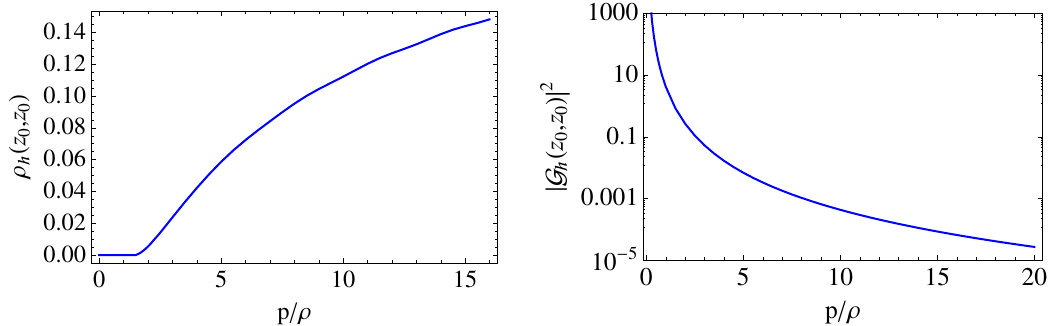
Figure 7 . Left panel: spectral density (cid:26) h ( z 0 ; z 0 ; p ) for a continuum graviton. Right panel: absolute value squared of the scale invariant Green’s function, G h ( z 0 ; z 0 ; p ), for the graviton. We have used A 1 = 35 and c =